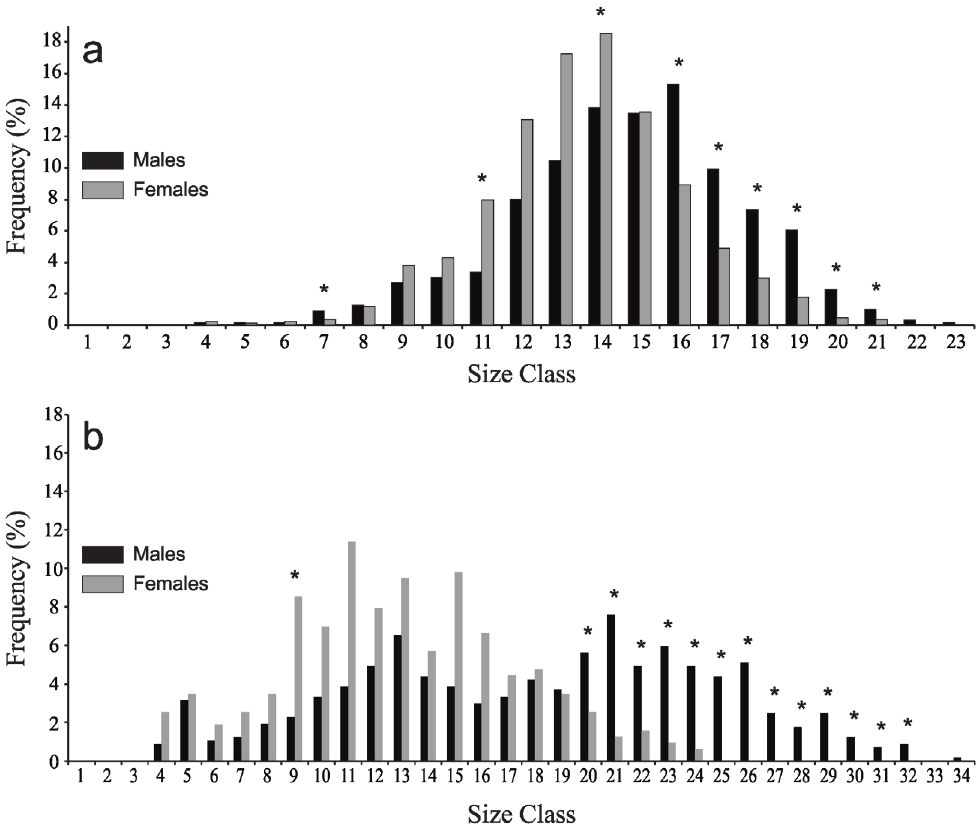
Figure 4. Aegla schmitti . Frequency distributions regarding the carapace of males and females and sex ratio in the size classes of the Arraial (a) and Capivari (b) rivers. The symbol * indicates statistically significant difference in the sex ratio. Size classes (mm): (1) 0 ┤ 1; (2) 1.01 ┤ 2; (3) 2.01 ┤ 3; (4) 3.01 ┤ 4; (5) 4.01 ┤ 5; (6) 5.01 ┤ 6; (7) 6.01 ┤